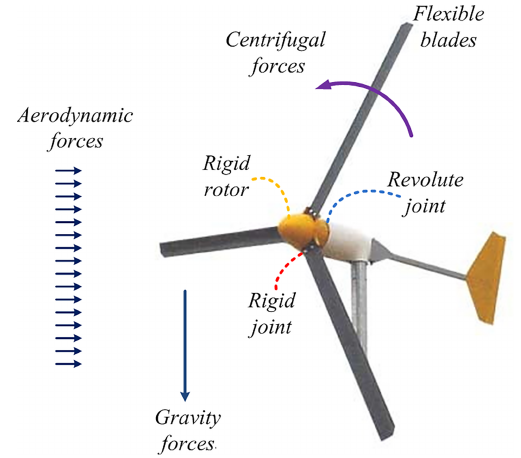
Figure 1. Small-size wind turbine as a multibody